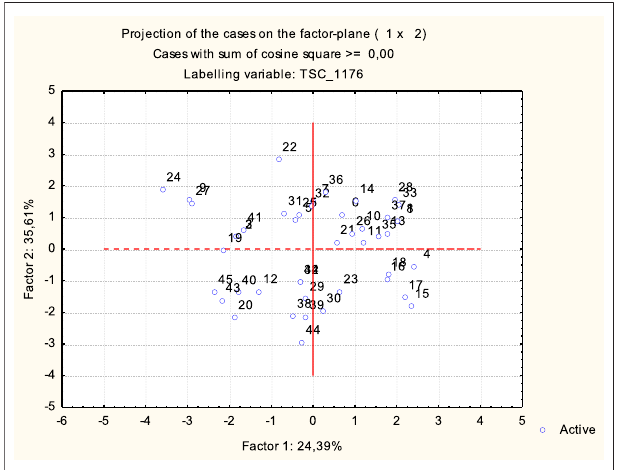
FIGURE 3 | Distribution of francophone organizations studied in